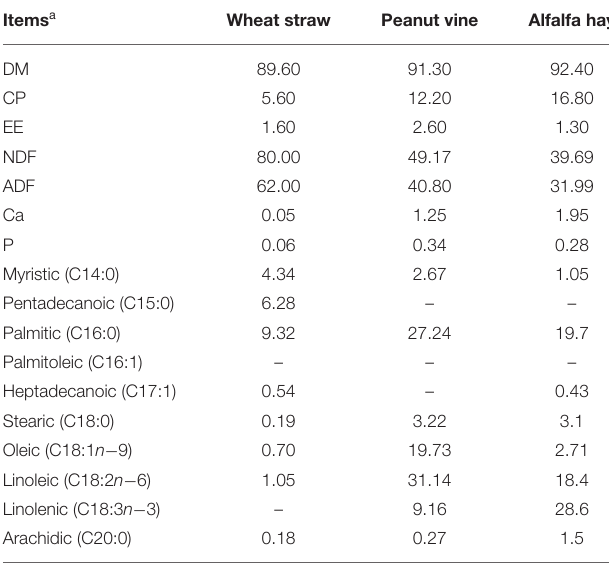
TABLE 1 | Nutrient compositions of three roughages (DM